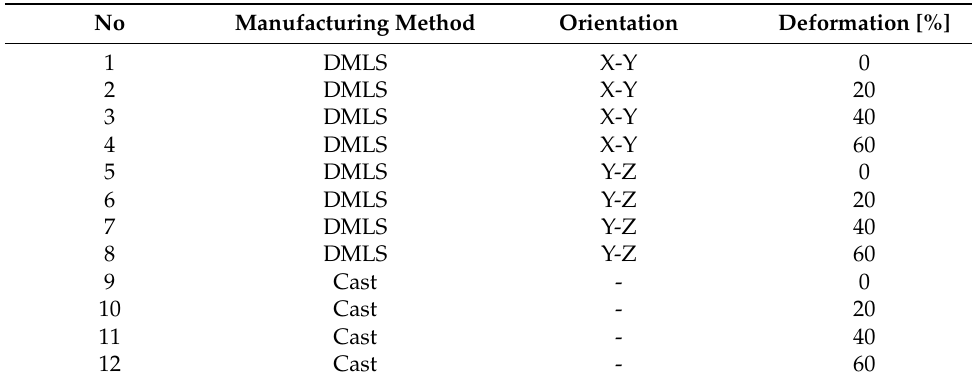
Table 2. Deformation plan of the DMLS and as-cast